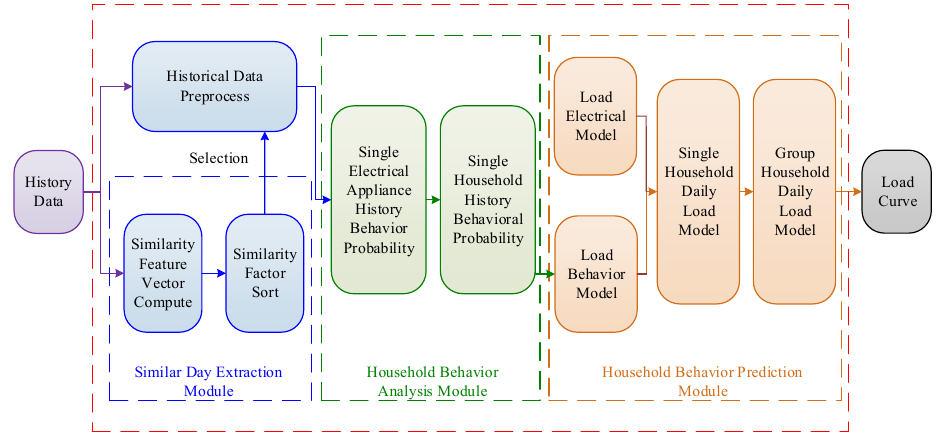
Figure 1. Forecasting framework of group household electricity